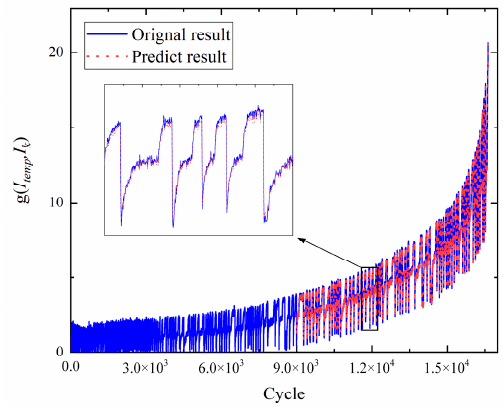
Figure 12. Predicted value and original value.